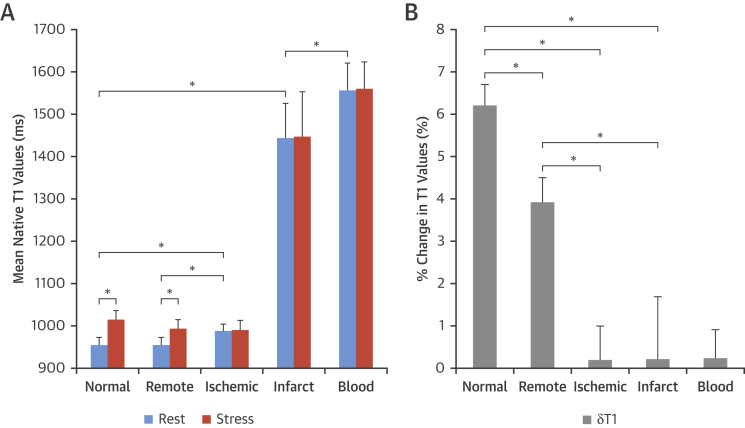
Myocardial T1 at Rest and During Adenosine Stress at 1.5-T(A) T1 values at rest in normal and remote tissue were similar and significantly lower than in ischemic regions. Infarct T1 was the highest of all myocardial tissue but lower than the reference left ventricular blood pool of patients. During adenosine stress, normal and remote myocardial T1 increased significantly from baseline, whereas T1 in ischemic and infarcted regions remained relatively unchanged. (B) Relative T1 reactivity (δT1) in the patient’s remote myocardium was significantly blunted compared with normal and was completely abolished in ischemic and infarcted regions. All data indicate mean ± 1 SD. *p < 0.05.